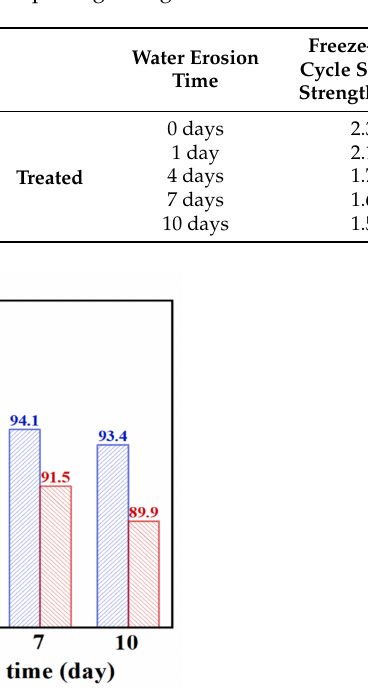
Table 10. Test results of freeze–thaw splitting strength.